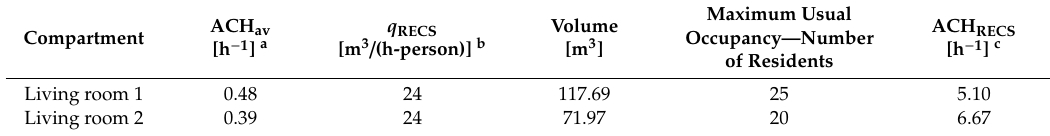
Table 11. Ventilation rates of living rooms 1 and 2 in ECC 2: 1 st trial.